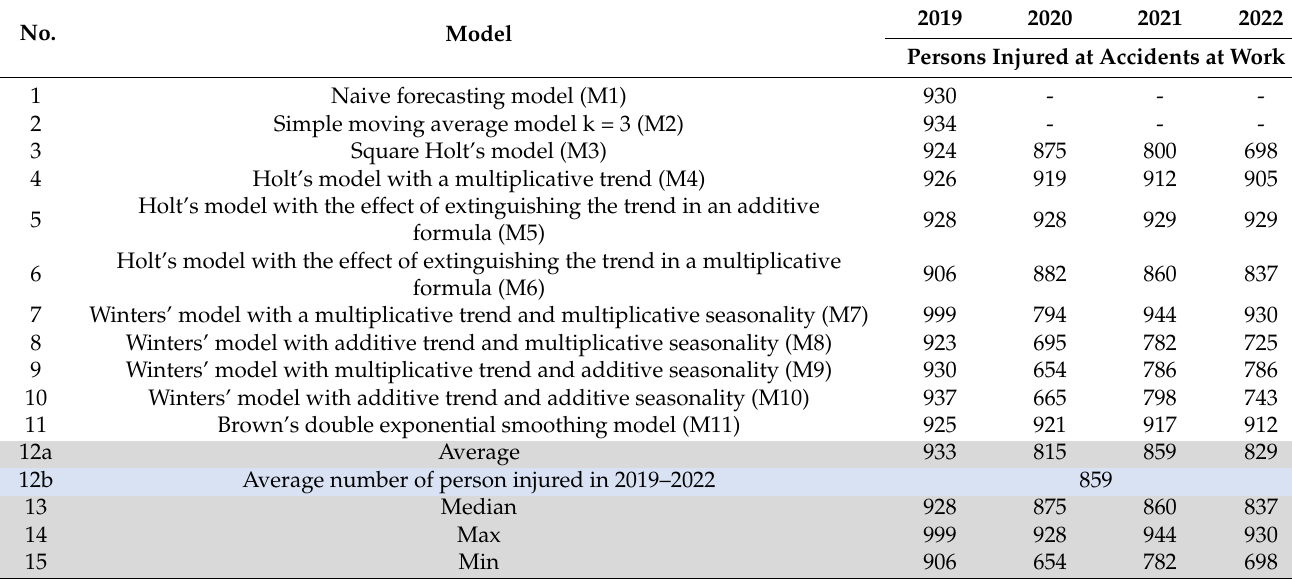
Table 4. Obtained forecasts for analyzed Polish steel sector (own elaboration).